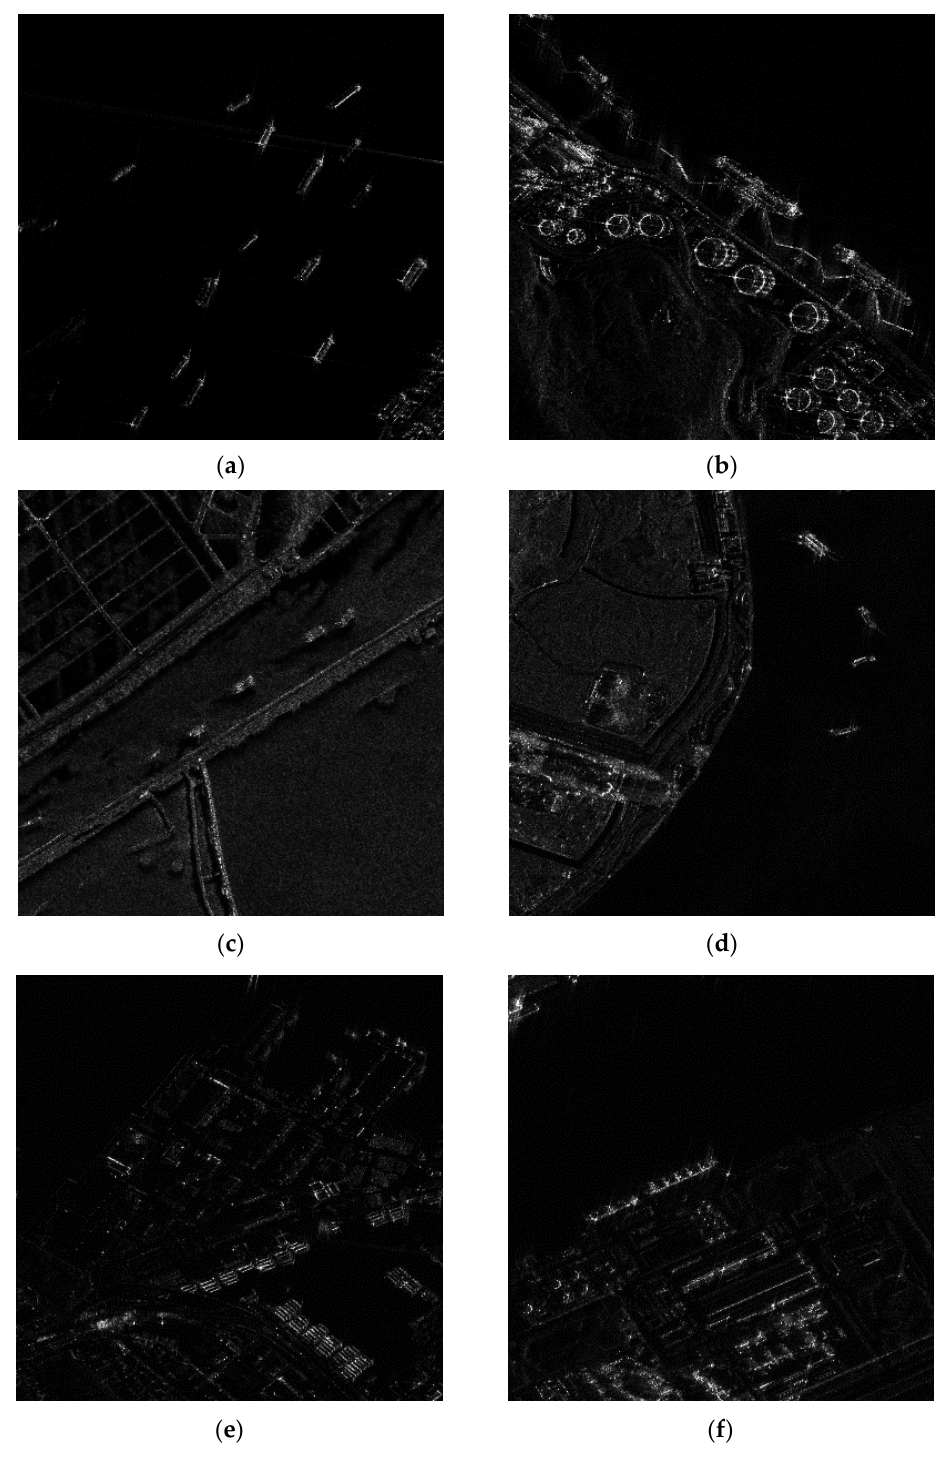
Figure 3. Some representative SAR slices in the dataset with 1024 × 1024 pixels. ( a ) SAR slice from Nanjing Yangtze River; ( b ) SAR slice from Zhoushan Port; ( c ) SAR slice from Macao; ( d ) SAR slice from Hongkong; ( e ), ( f ) SAR slices from Yokohama Port.